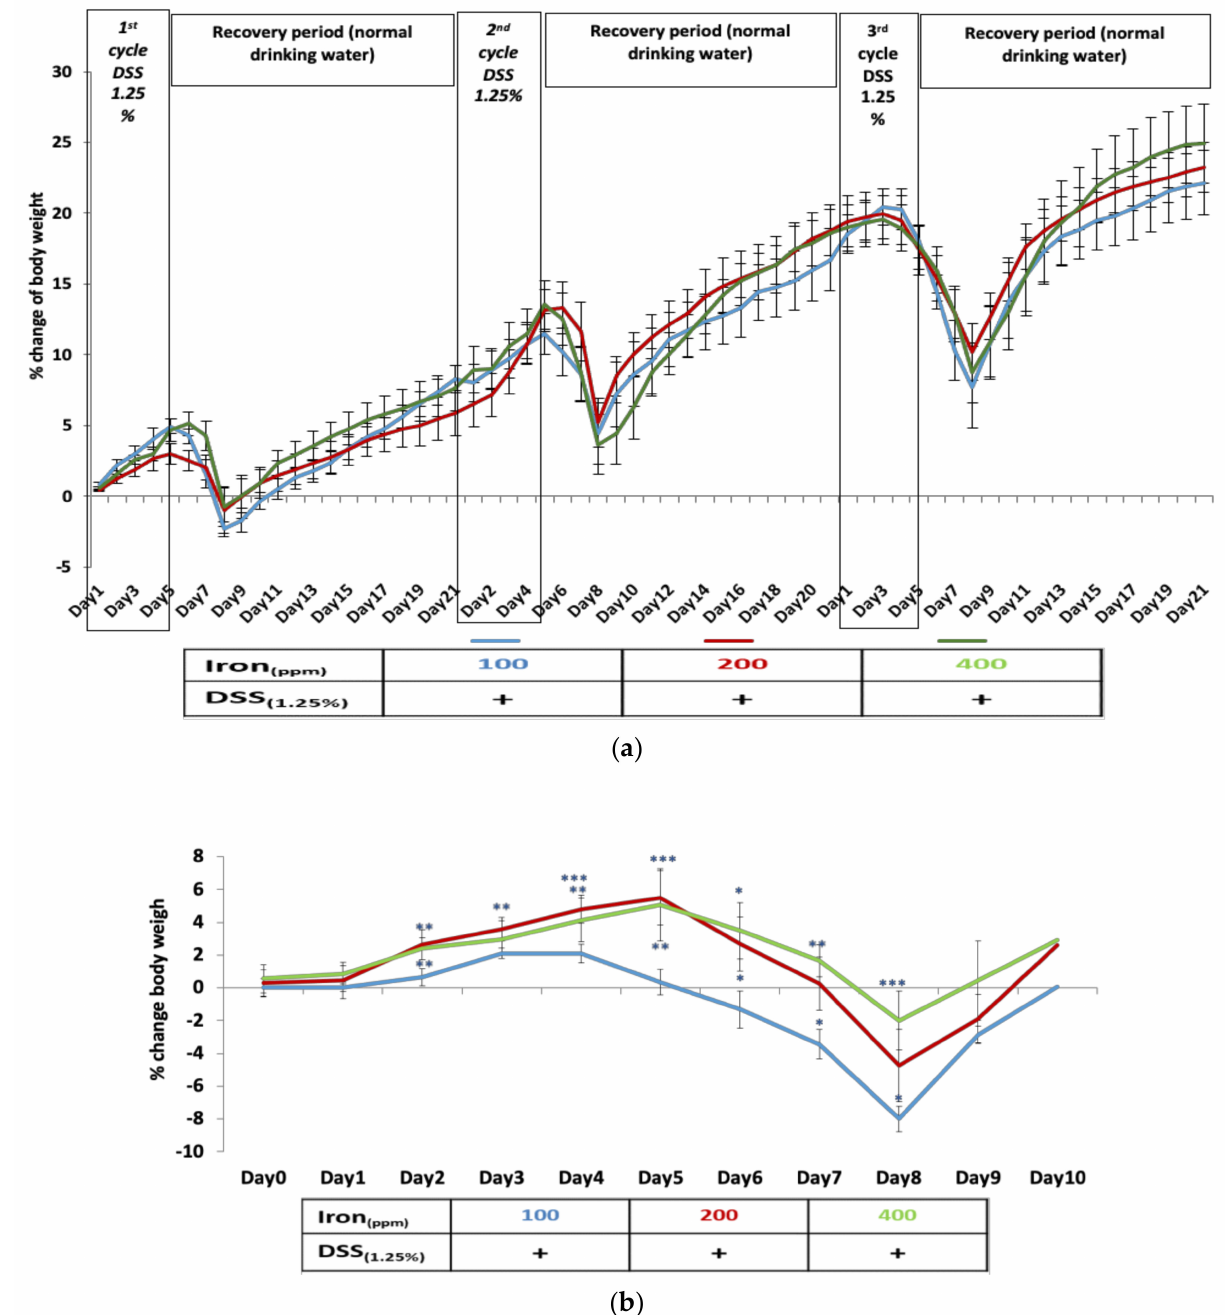
Figure 1. Dextran sulfate sodium (DSS) colitis – induced body weight changes in mice consuming diets of differing dietary iron levels. ( a ) Percentage weight loss observed in mice with chronic colitis induced by three cycles of 1.25% w / v DSS during the 63-day period was not influenced by consumption of an iron-deficient diet (100 ppm iron [blue]), standard chow diet (200 ppm iron [red]) nor an iron supplemented diet (400 ppm iron [green]); Data presented as mean ± standard error of the mean (SEM). No statistical differences were seen between groups ( n = 8 mice per group). ( b ) Percentage body weight loss in mice resulting from DSS-induced acute colitis on 63 days on deficient and supplemented iron diets compared with standard chow ( n = 4 female mice per group). Statistical differences * p < 0.05, ** p < 0.01, *** p < 0.001; Kruskal–Wallis test followed by multiple comparison